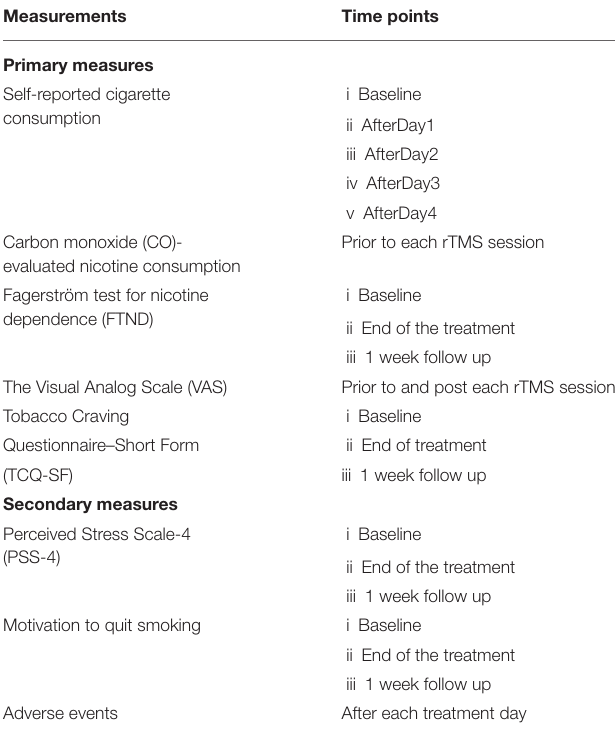
TABLE 2 | Overview of data collection time